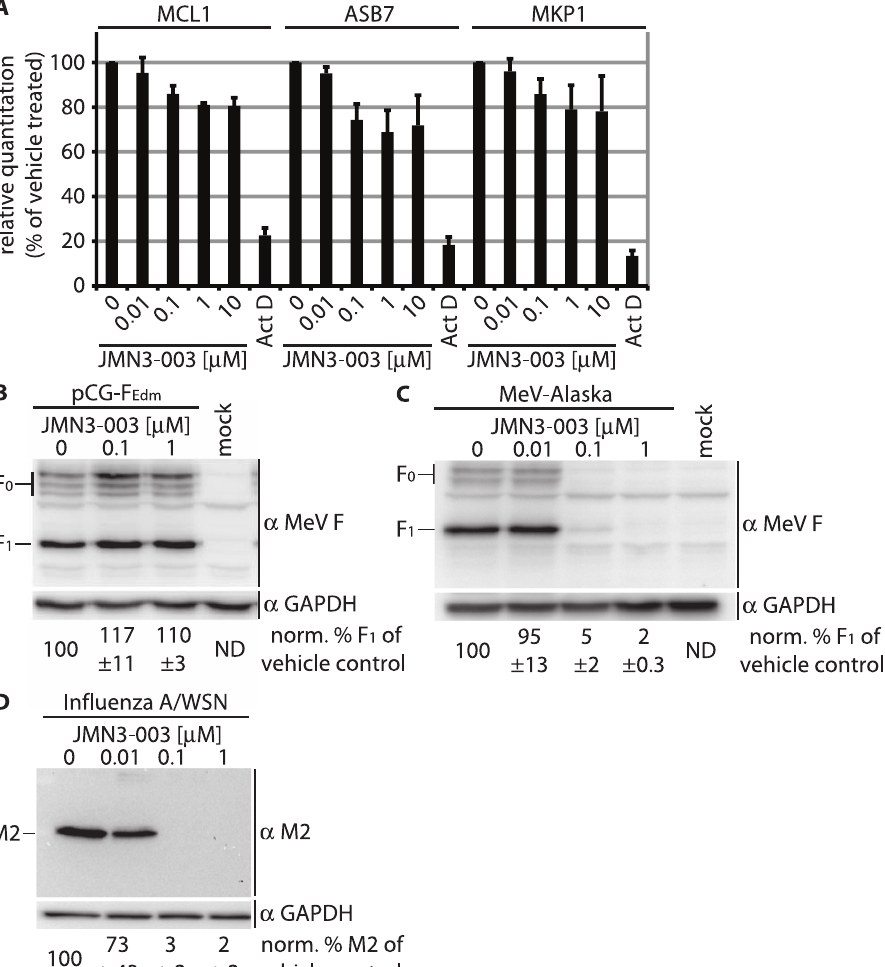
Figure 5. Host cell mRNA synthesis and translation are unaffected by compound JMN3-003. A ) Relative TaqMan RT-PCR-based quantitation of three unstable cellular mRNAs (MCL1, ASB7, MKP-1) after exposure of cells to JMN3-003 for six hours. Controls were treated with Actinomycine D (Act D) for comparison. C T values are expressed relative to vehicle-treated samples and reflect averages of three independent experiments, each analyzed in triplicate, 6 SD. B–D ) Expression of virus-encoded but not host cell or plasmid-encoded viral proteins is blocked by JMN3-003. Immunodetection of transiently expressed MeV-F ( B ), virus-encoded MeV-F ( C ), and virus-encoded influenza A/WSN M2 ( D ) in cell lysates after incubation of cells in the presence of compound or vehicle only (DMSO) for 30 hours. As internal cellular standard, membranes were probed for GAPDH in parallel. Numbers correspond to average densitometric quantitations 6 SD of three experiments, representative immunoblots are shown. (ND: not determined).